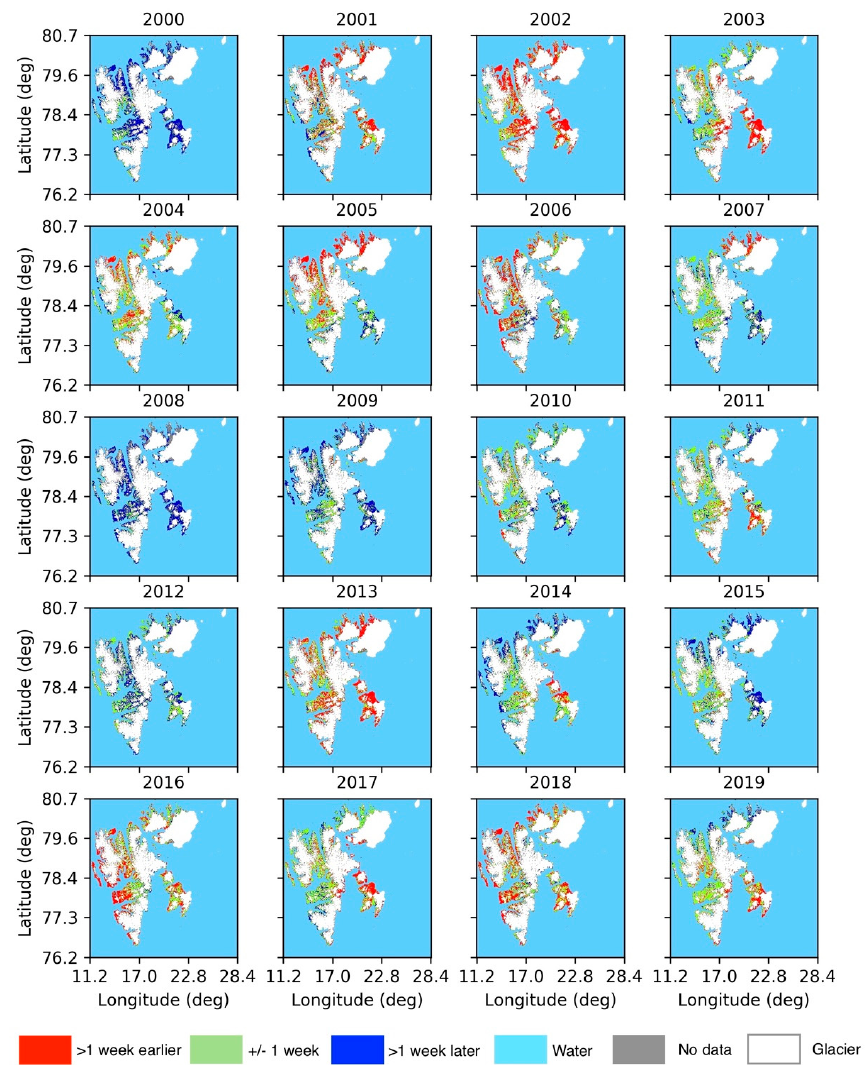
Figure 7. Figure showing the anomalies in first snow-free day compared with the mean first snow-free day over the period 2000–2019.